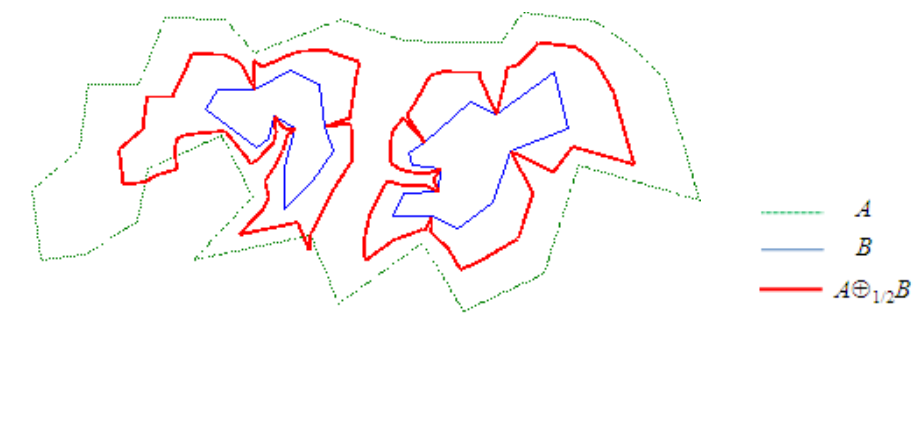
B , where A is a simple polygon and B consists of two simple polygons Figure 3. A ⊕ 1 / 2 included in A